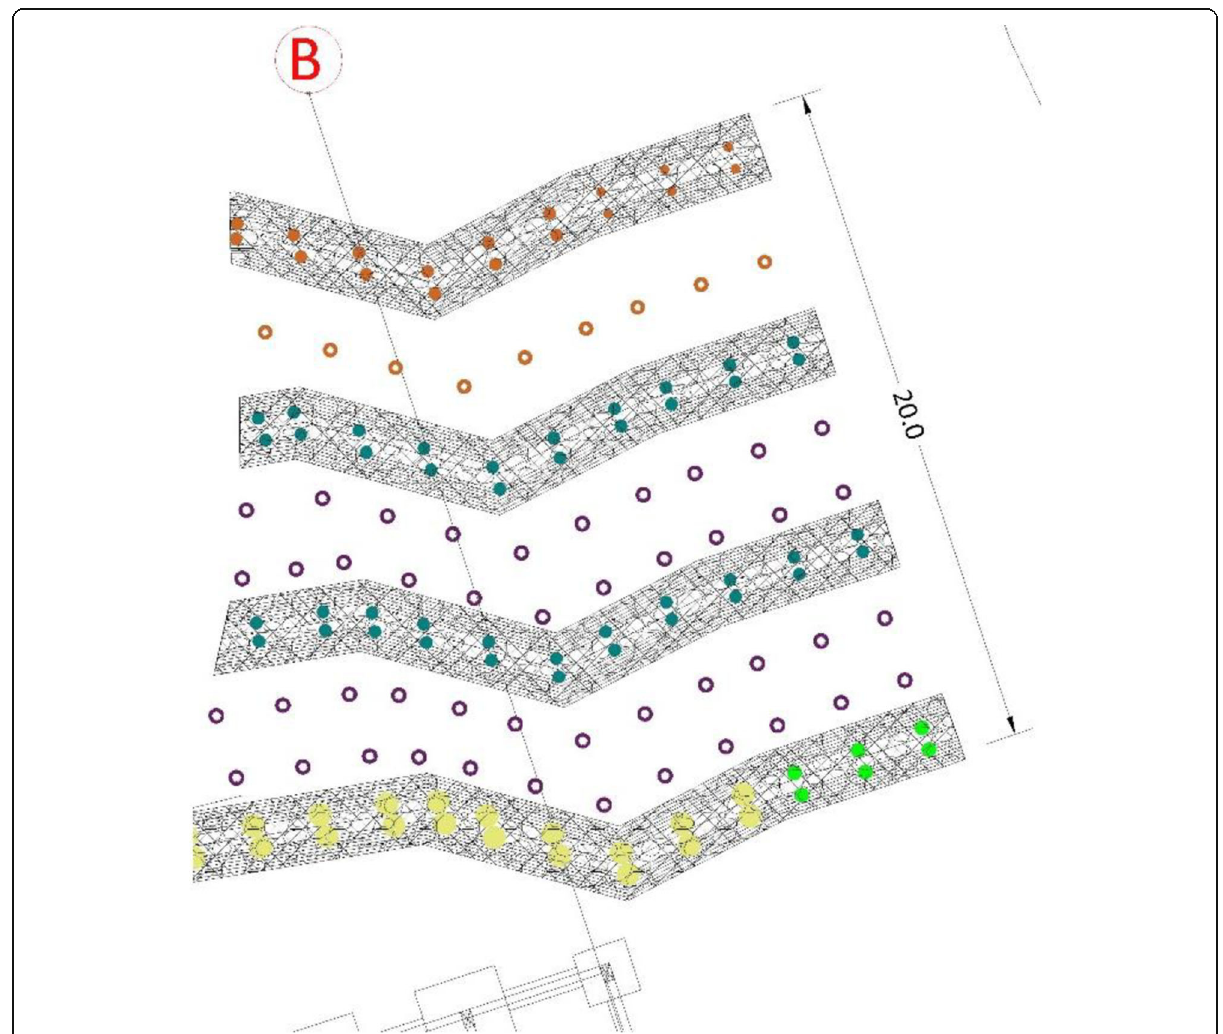
Fig. 9 Micropile, geocell wall layout